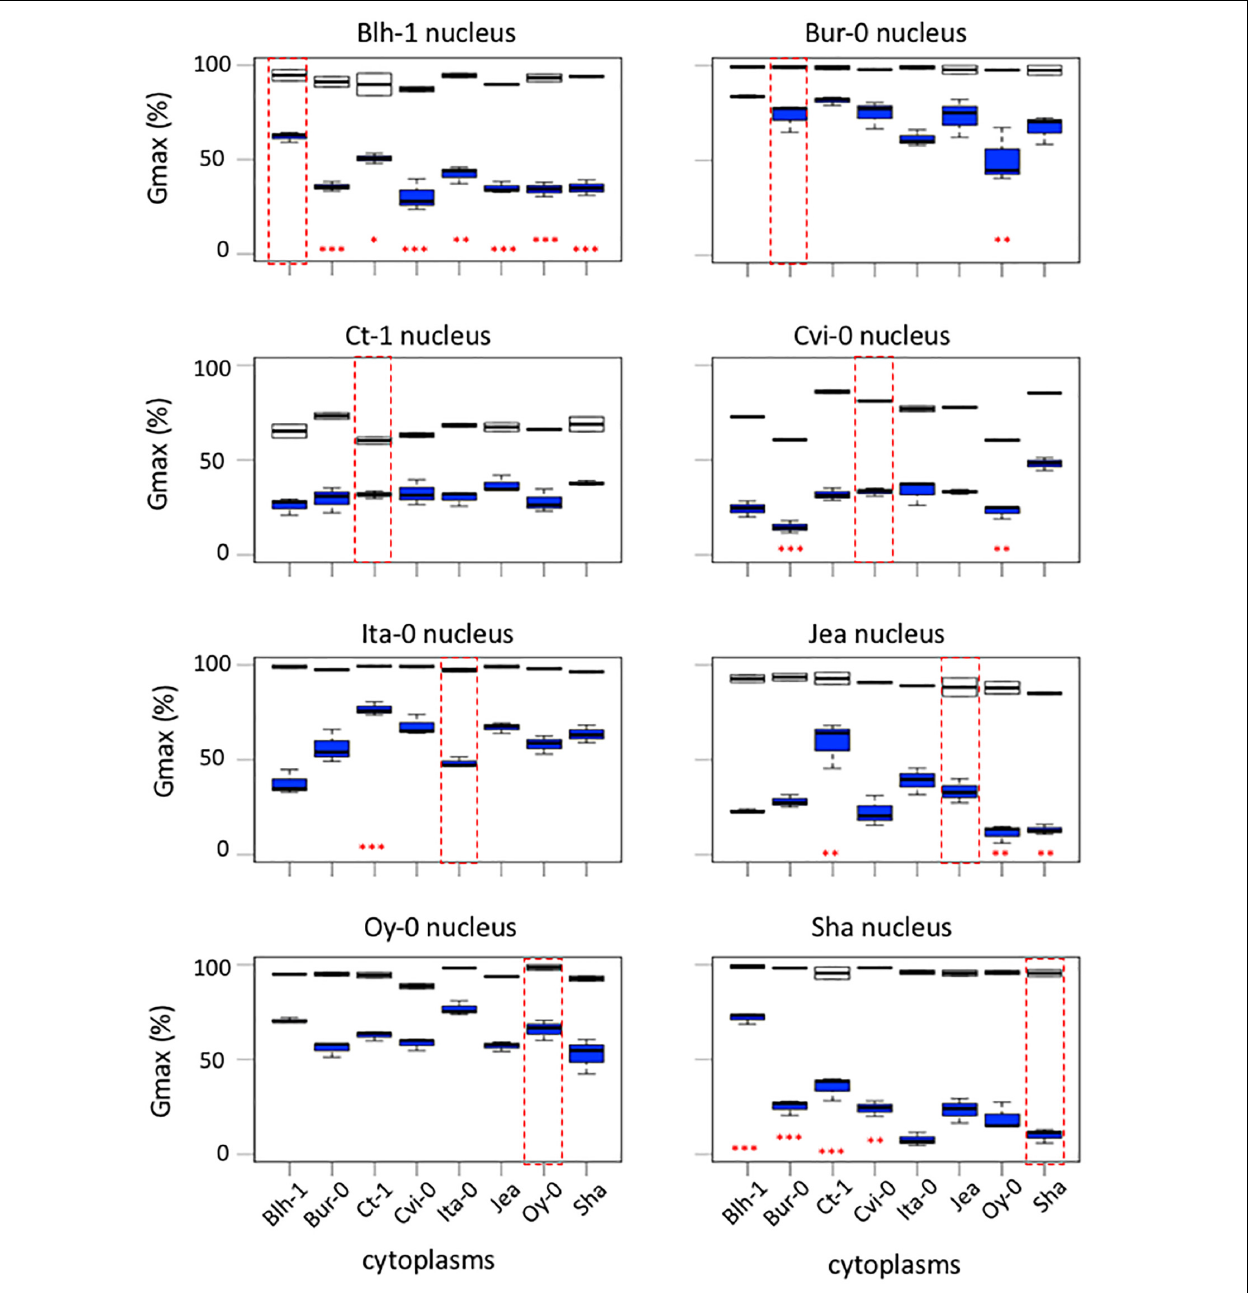
FIGURE 2 | Germination performance of cytoline series. Each panel shows boxplots of the maximum germination percentage (Gmax) of a nuclear series of cytolines, highlighting the natural parental accession in a red dotted frame. White, germination on water; blue, germination on NaCl. Significant differences of germination performance, averaged on the presence of salt, of cytolines compared to their nuclear natural parent are indicated with red stars. P -value: ∗∗∗ < 0.001, ∗∗ < 0.01, ∗ < 0.05 (see Supplementary Methods S1 for